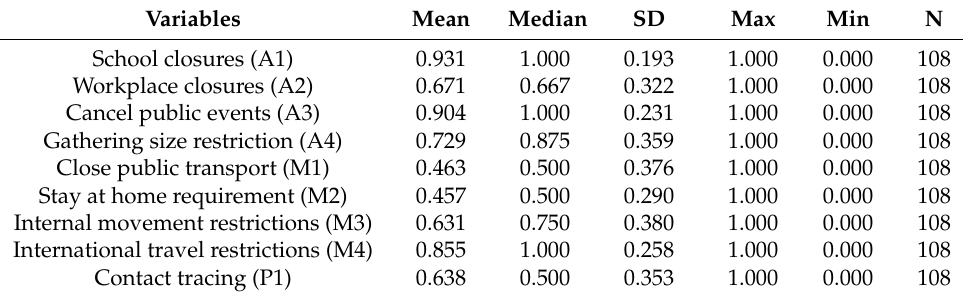
Table 2. Descriptive statistics of the regression